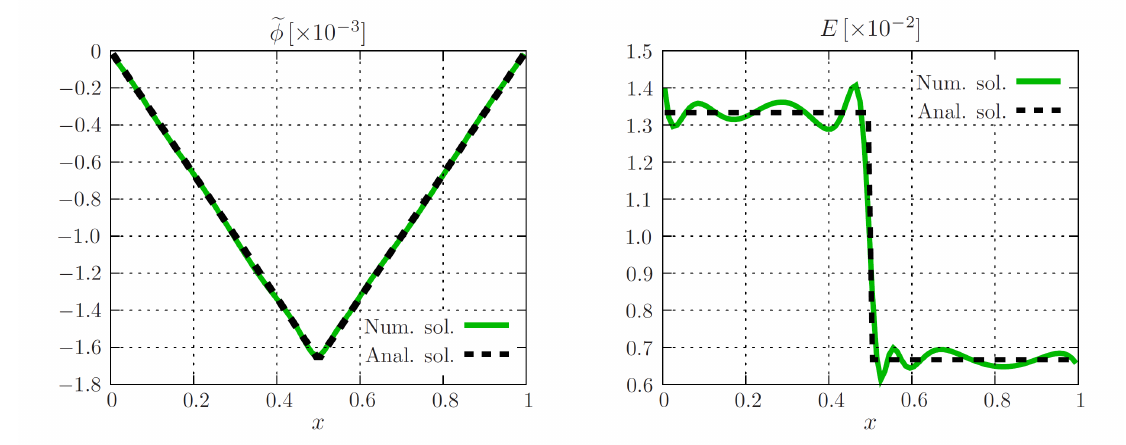
Figure 3. Numerical vs. analytical solution for a global trial function approach using an SLPs with 10 neurons and a random initialization of p ( 0 ) ∼ U ( 0,1 ) , where U ( 0,1 ) denotes a vector of numbers generated from a uniform distribution between 0 and 1. These parameters are statistically